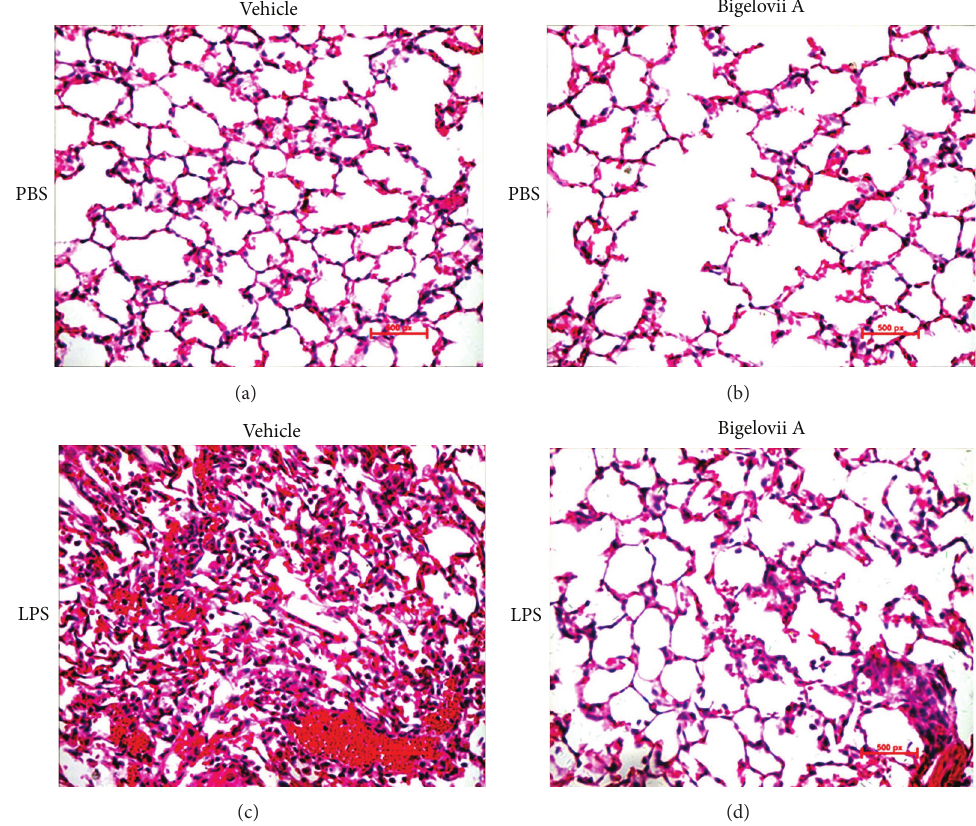
Figure 2: Effect of Bigelovii A on LPS-induced histological change. ALI was induced by intratracheal administration of LPS. 18 h later, lung tissues were prepared as described in Section 2 (original magnification × 400). Lung sections were Vehicle plus PBS (negative control) (a), Bigelovii A+PBS (b), LPS+Vehicle (positive control) (c), and LPS+Bigelovii A (d),